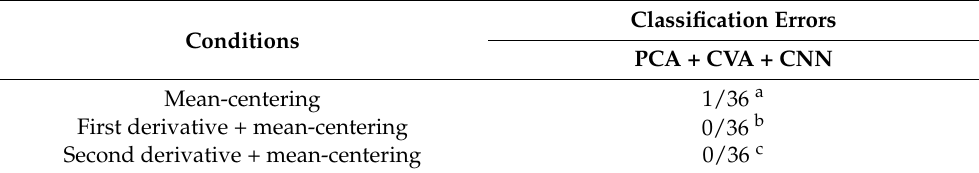
Table 5. Study #2: Prediction set classification errors (36 samples).